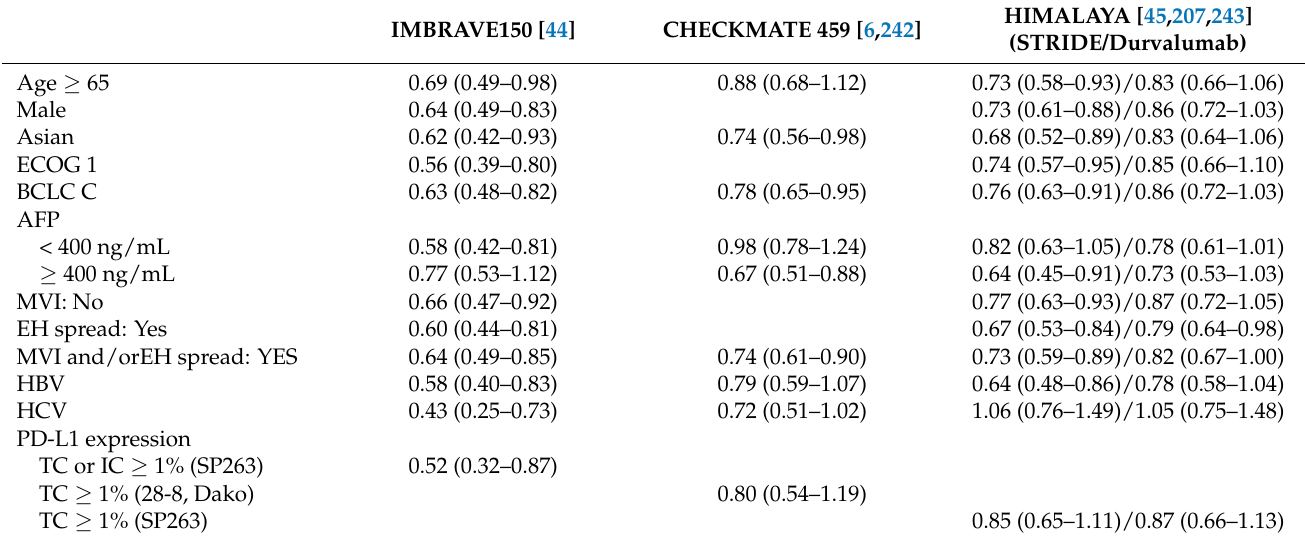
Table 1. HR of subgroups related to predict OS in recent phase 3 studies for immunotherapy in HCC (Immunotherapy versus sorafenib). IMBRAVE150 [44] CHECKMATE 459 [6,242]